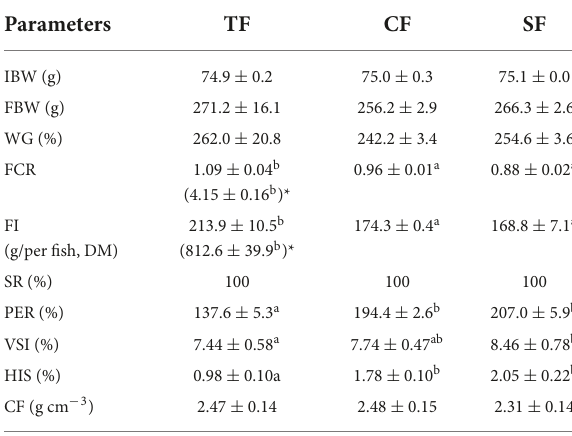
TABLE 3 Growth performance and morphologic indexes of largemouth bass fed trash fish and formula feeds.